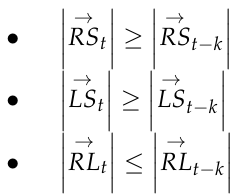
Figure 10. Triangle defined by the joints SHOULDER_RIGHT, SPINE_SHOULDER, and SHOUDER_LEFT (from a top view). On the left, a representation of the resting state of these joints. On the right, deformation caused by the correct execution of a scapular retraction.